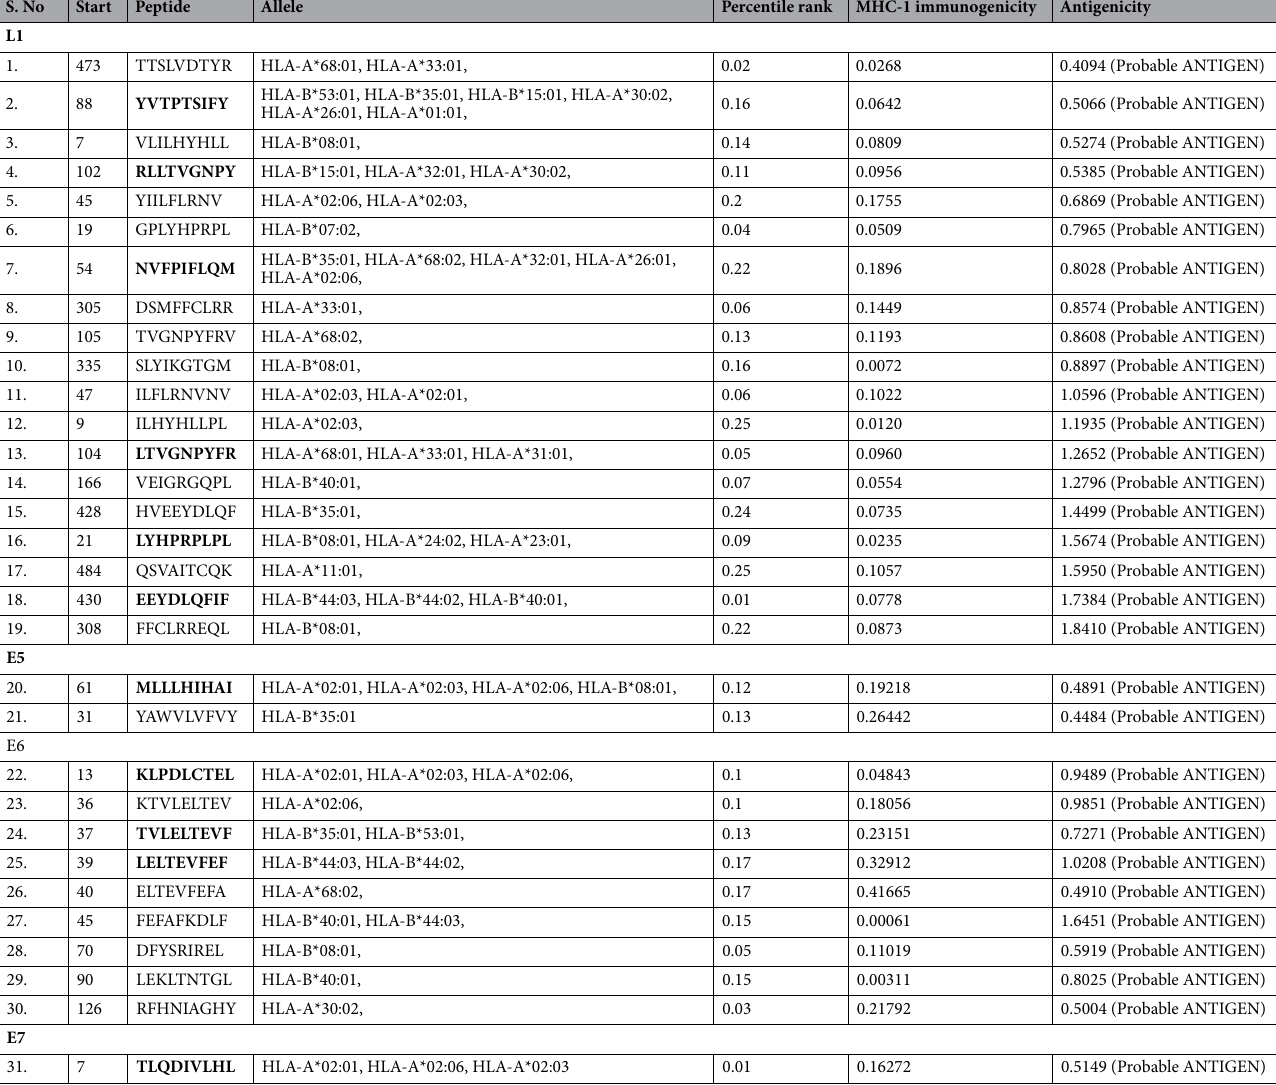
Table 2. MHC-I epitopes of L1, E5, E6, & E7 proteins of HPV 18. Bold text represents the peptides used in vaccine construct.